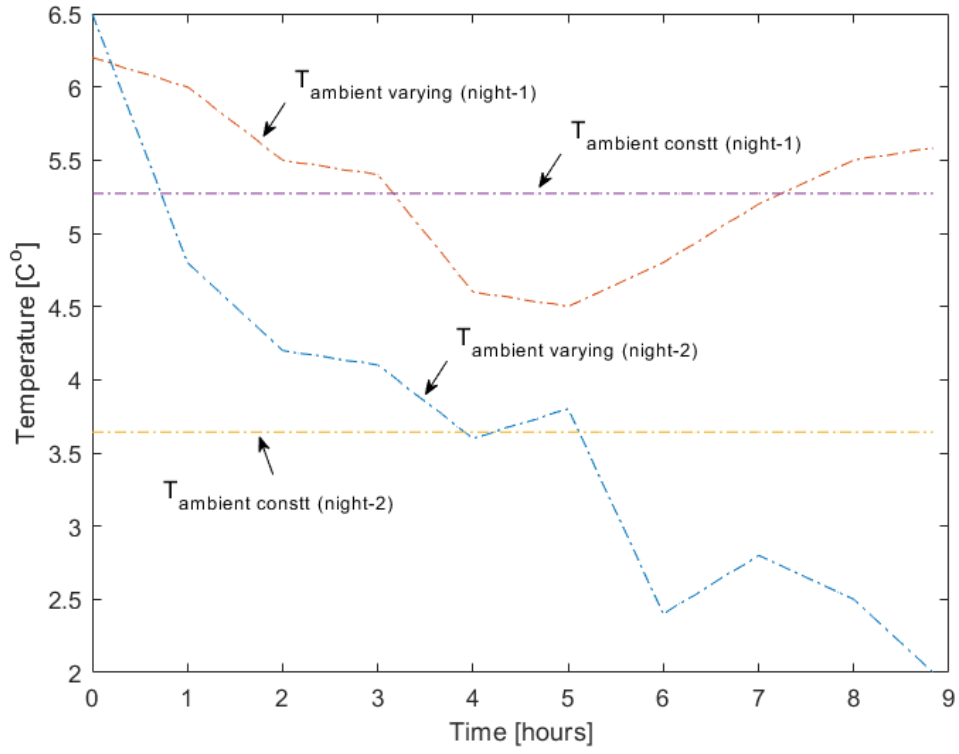
Figure 4. Temperature variation during a typical night for QUB experiment; horizontal dashed line shows the assumed constant temperature during QUB night.